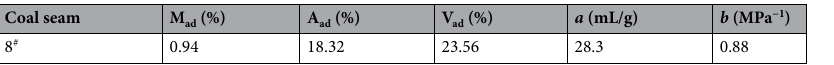
Table 1. Proximate analysis and adsorption parameters of the 8 # coal seam. Mad, Aad and Vad are the